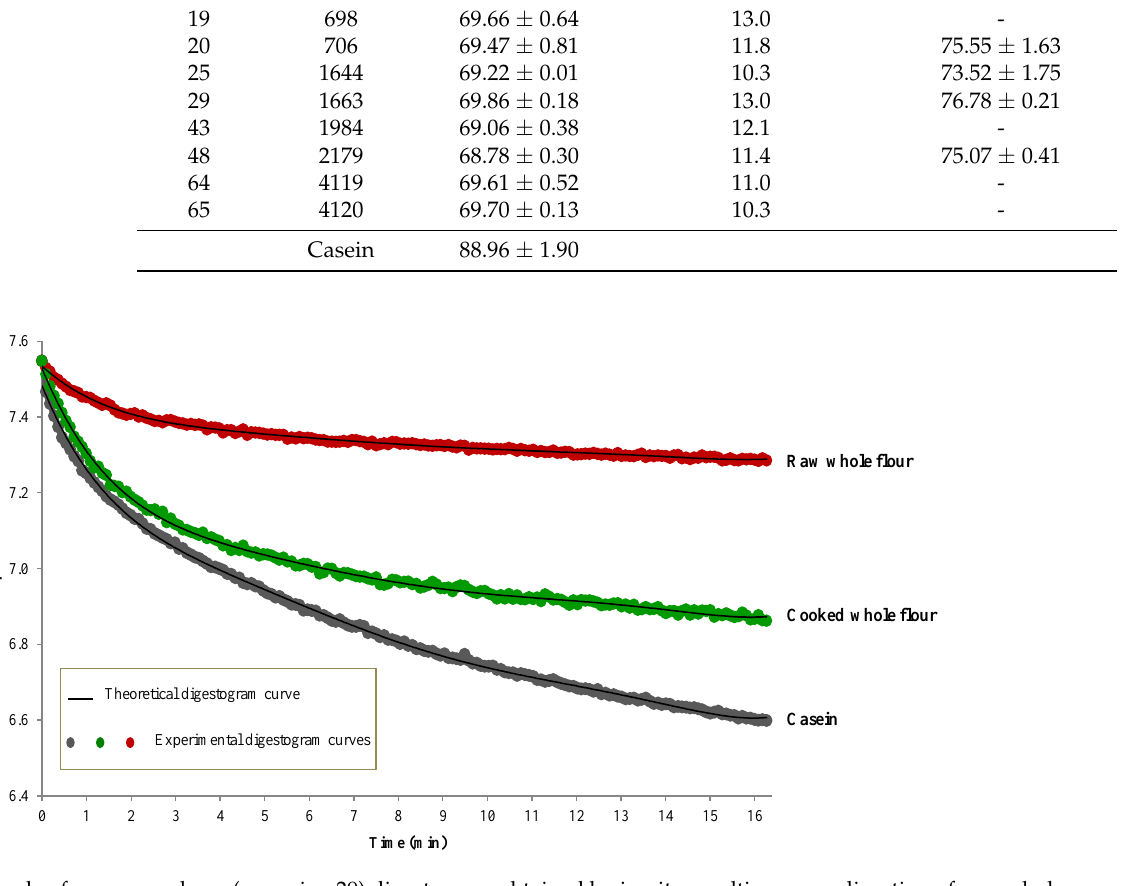
Figure 5. Example of a common bean (accession 29) digestogram obtained by in vitro multi-enzyme digestion of raw whole flour and corresponding cooked whole flour. Casein’s digestogram was also included for data comparison.